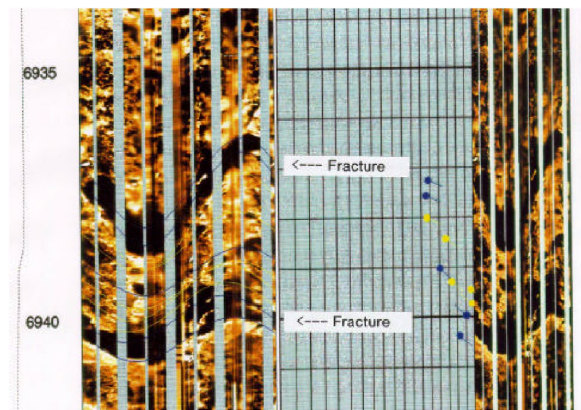
Fig. 2 Schematic of fault location on horizontal well (before comple- tion installation) (Pedersen et al. 2009) Fig. 3 Fractures of a fault zone identified in a borehole image (O'Brien et al.